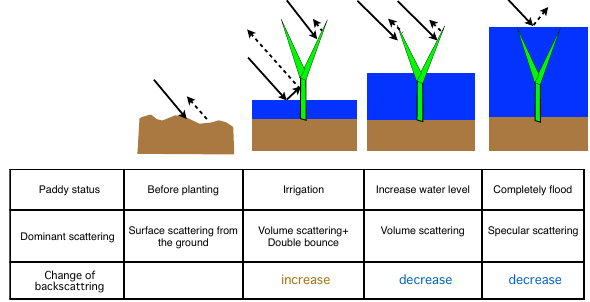
Figure 3. Change of backscattering mechanisms of rice paddy ガンマノート抽出場所 Fig. 3 fields.